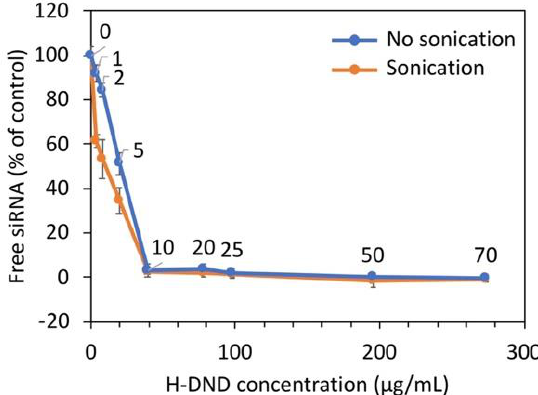
Figure 1. Binding of siRNA to hydrogenated detonation nanodiamonds (H-DND). Free siRNA as function of increasing quantity of H-DND (H-DND-22 samples) added to a fixed initial quantity of siRNA. The results are presented as the percentage of initial siRNA. Orange/blue with or without (respectively) sonication during the siRNA to H-DND complexation. Experiments were performed in triplicates. Number over each point represent the mass ratio m H-DND / m siRNA . The statistical comparison tests between sonicated and non-sonicated conditions yield p = 0.021 (*) for mass ratio 1:1 to 5:1 and non-significant di ff erences starting from mass ratio 10:1 to higher